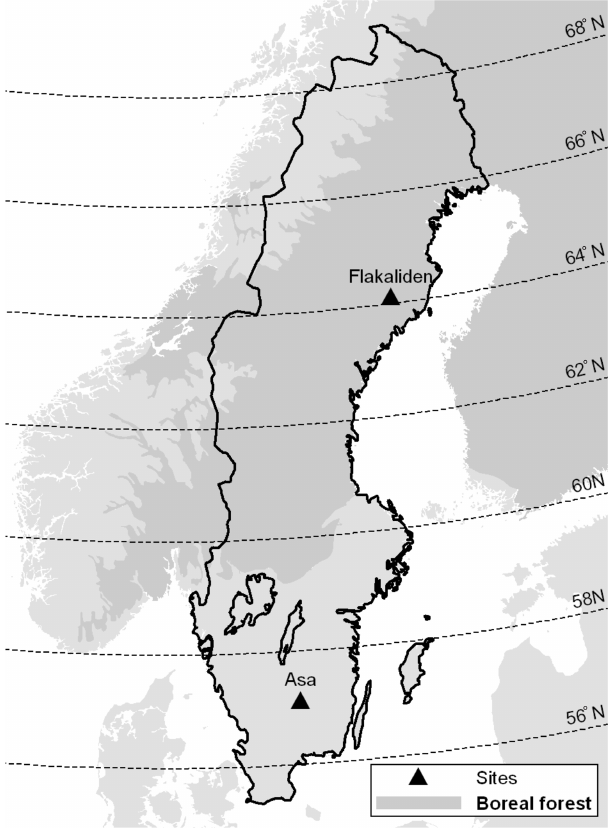
Figure 1. Map of Scandinavia showing the location of the study sites Asa and